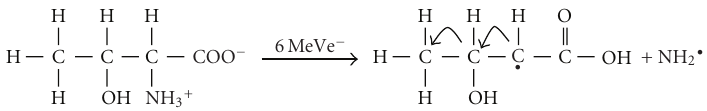
Figure 40: Deaminated free radical formation due to electron irradiation in L-threonine. Table 8: Dispersion of second order NLO parameters with wavelength. Figure of merit of SHG Figure of merit of EO